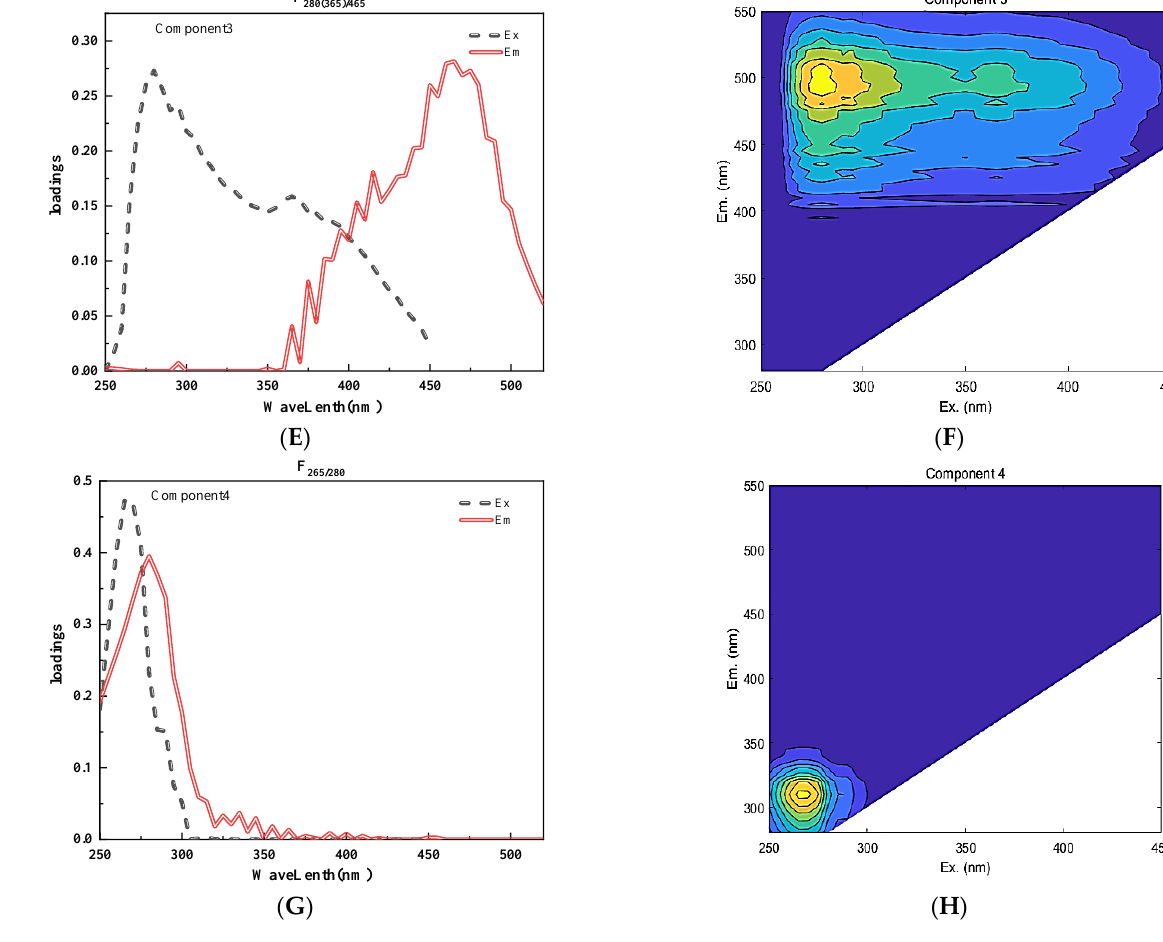
Figure 2. Four component maps and split-half test maps identified by PARAFAC. (A) Split-half test diagram of C1 component, (B) C1 fluorescence component diagram, (C) Split-half test diagram of C2 component, (D) C2 fluorescence component diagram, (E) Split-half test diagram of C3 component, (F) C3 fluorescence component diagram, (G) Split-half test diagram of C4 component, (H) C4 fluorescence component diagram. F represents the position of the fluorescence peak, Ex represents the excitation wavelength, and Em represents the emission wavelength.